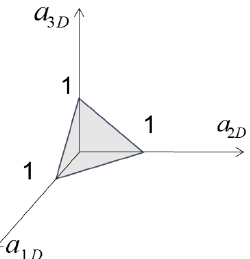
Figure2. The map of dimension feature value distribution and the density of the adjacent two points is relatively